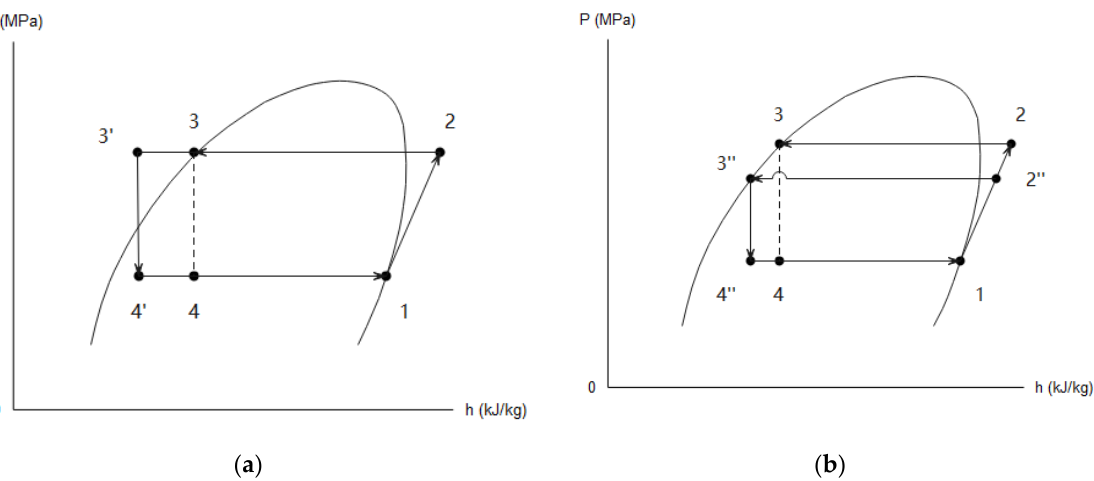
Figure 6. TDT-RAC cycles (P-h diagram) with: ( a ) fixed speed compressors (1 → 2 → 3 ′ → 4 ′ → 1); ( b ) variable speed compressors (1 → 2 ″ → 3 ″ → 4 ″ → 1).